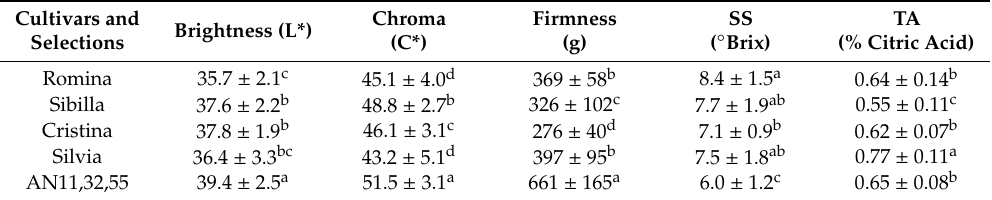
Table 1. Results of fruit color (Brightness and Chroma), firmness, Soluble Solids Content (SS), and Titratable Acidity (TA). Data are expressed as means of 80 fruits ± standard deviation. Di ff erent superscript letters indicate significant di ff erences at p < 0.05 (Tukey